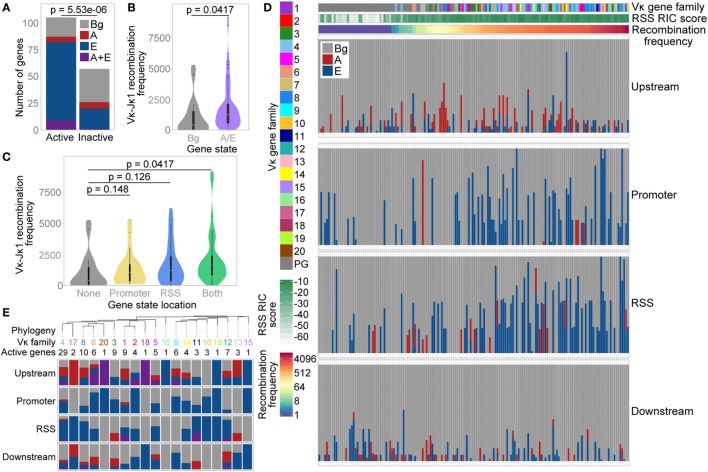
Vκ gene chromatin state is associated with recombination frequency. (A) Number of active and inactive genes in each state. p-value based on a Fisher’s exact test. (B,C) Violin plots with boxplot superimposed (black) showing median recombination frequencies of active genes in the Bg state compared to active genes associated with the A and/or E state. A and/or E state genes are considered altogether (B), or categorised based on the localisation of the state to their promoter or recombination signal sequence (RSS) (C). 10 genes that had <70% mappability were excluded. Fdr-adjusted p-values based on two-sided Wilcoxon rank sum test. (D) Proportion of each Vκ gene promoter and RSS (each window extending from the gene centre to 500 bp up/downstream of the gene, respectively; median window size 762 bp) and up- and downstream regions (from 500 to 3,500 bp up/downstream of the gene) that are assigned to each of the three states. Each bar represents an individual Vκ gene. Note that up- and downstream windows represent a genomic region approximately four times the size of the promoter and RSS windows. Genes are ordered based on their recombination frequency, with highly recombining genes on the right (denoted by red shading on the recombination frequency scale). Vκ gene family and RSS Information Content (RIC) score are indicated to the left and above. (E) Top: phylogenetic tree of reference C57BL/6 Vκ gene sequences, collapsed at the nodes containing the majority of each Vκ gene family. The number of active genes in each family is shown. All nodes comprise a single Vκ gene family except for one node, the Vκ9 family branch, which also includes Vκ14-130. Bottom: proportion of active genes in each family that are associated with the A state, E state, or with both states at their promoters, RSSs and up/downstream regions [colours as in (A)].